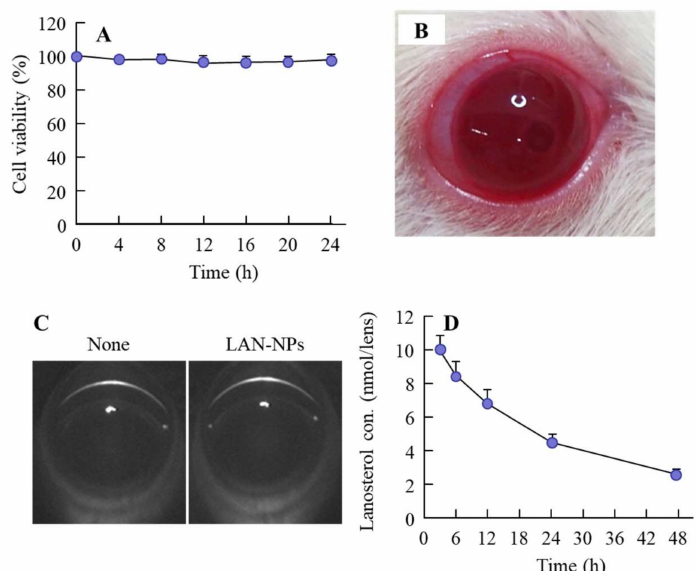
Figure 2. Potential adaptability of LAN-NPs as an intravitreal injection formulation. ( A ) Viability of HLE cells treated with LAN-NPs. ( B , C ) Eye image (B) and Scheimpflug slit images (C) of rats immediately after the intravitreal injection of LAN-NPs. ( D ) Changes in lanosterol concentration in the lenses of rats intravitreously injected with LAN-NPs. None, non-injected rats with slight lens structure collapse (SCR-N); LAN-NPs, LAN-NP injected SCR-N; n = 6. No cell toxicity was observed after treating human lens epithelial cell line SRA 01 / 04 (HLE) with LAN-NPs, and no inflammation or opacity was observed after intravitreal injection in SCR-N. Lanosterol levels in the lenses retained their increase for 0–48 h following the intravitreal injection of